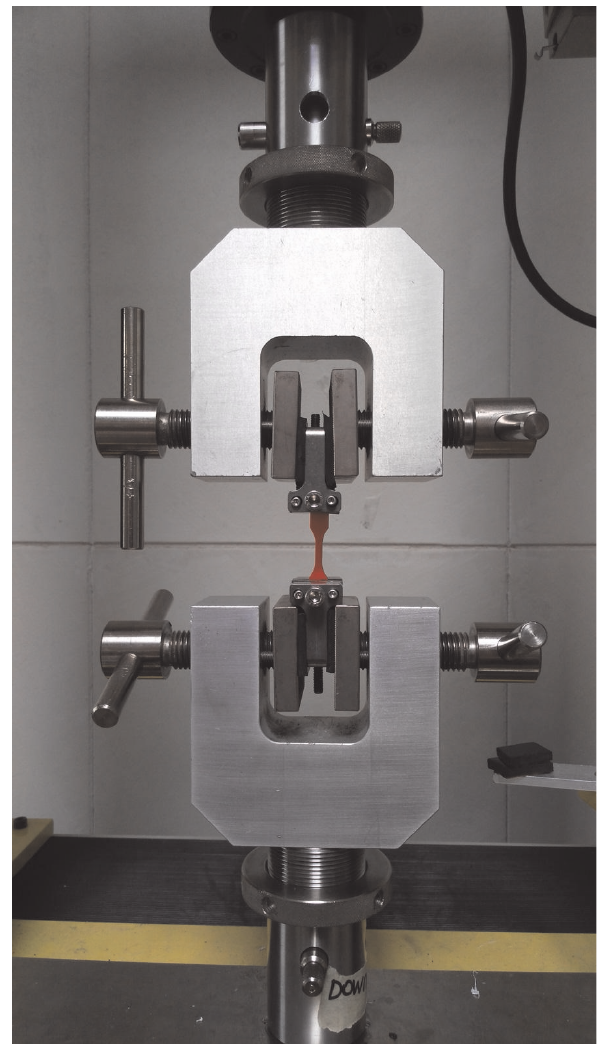
Figure 5: Artisan QTest10 testing machine during an experimental